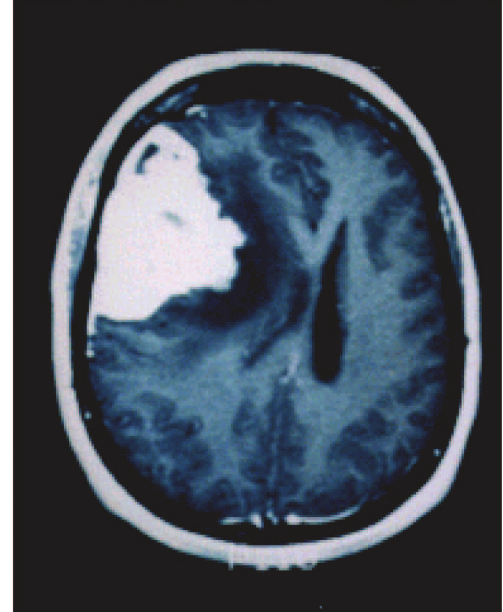
Figure 3 - Mmagnetic resonance imaging showing large malignant meningioma with important peritumoral edema and deviation of the middle line